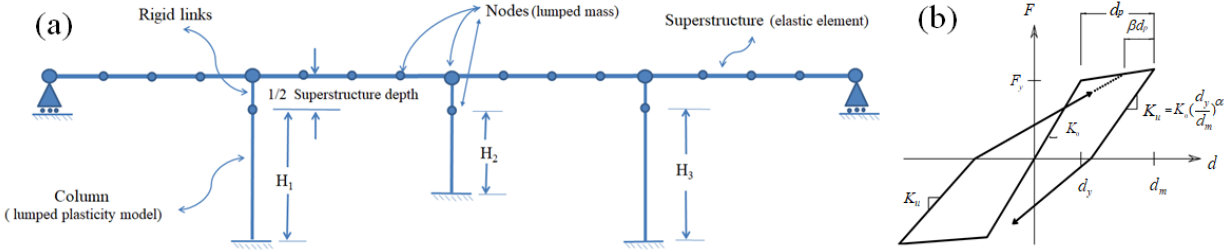
Figure 2. Structural modelling of the bridges: ( a ) Schematic presentation of the structural modelling of the bridge in the Ruaumoko program (adapted from [12]); ( b ) modified Takeda hysteresis loop (adapted from [17]).